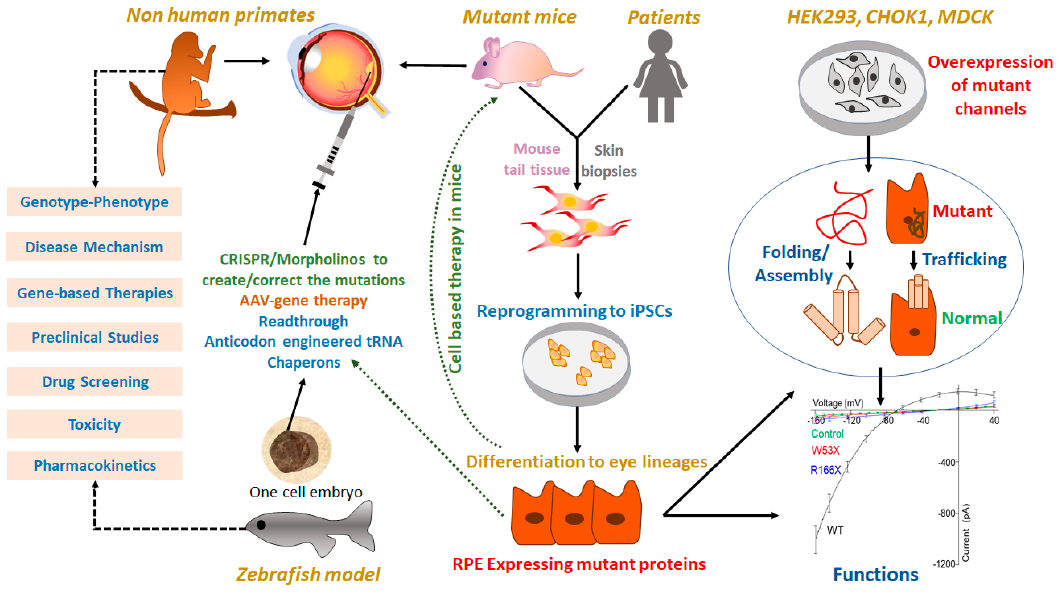
Figure 6. Disease models recapitulating human channelopathies and therapeutics.